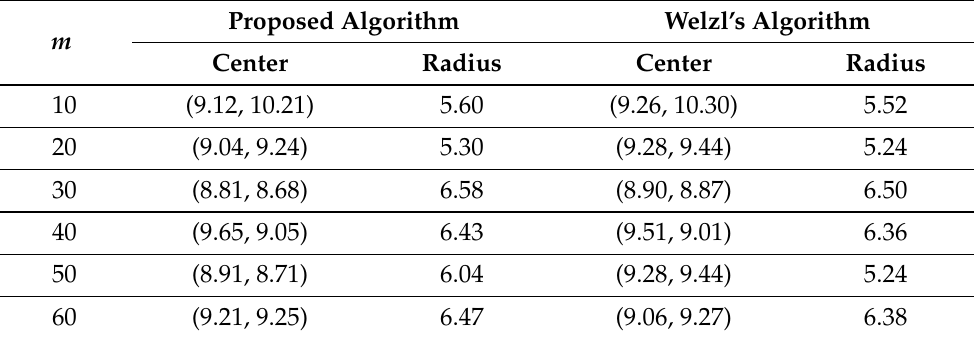
Table 3. Smallest circle details obtained by the proposed algorithm and Welzl’s